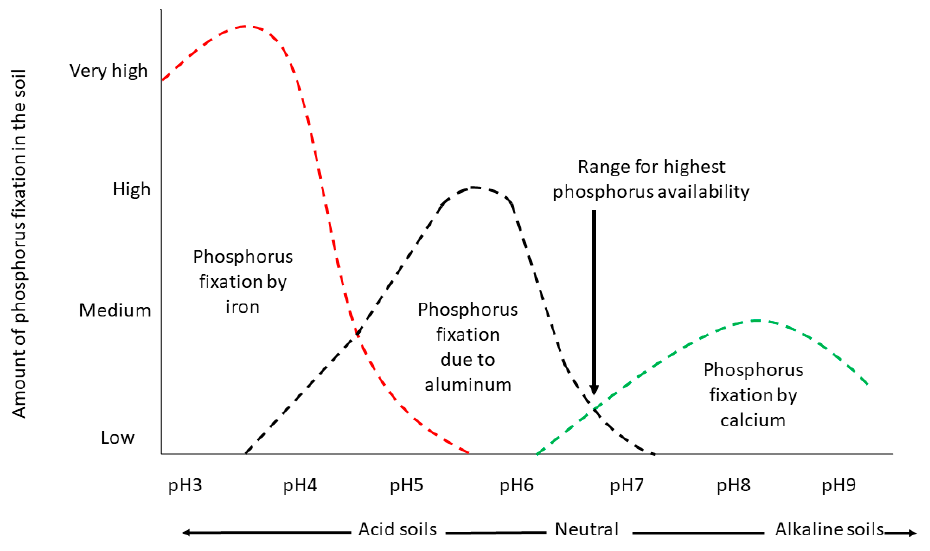
Figure 1. General qualitative representation of soil phosphorus availability as impacted by pH. Redrawn from Price [1].